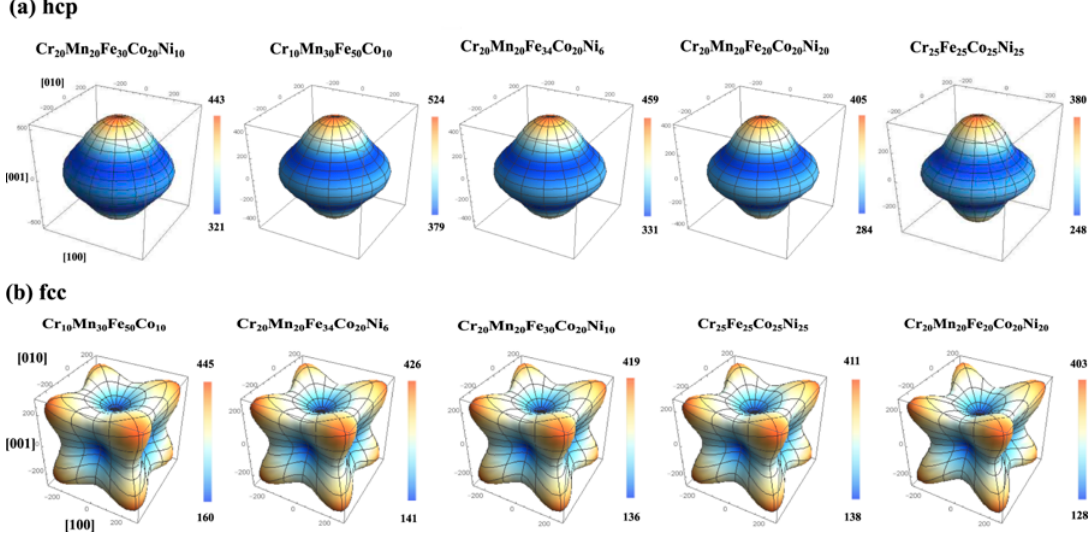
Figure 8. Directional dependence of Young’s modulus E (in GPa) of some MPE alloys in hcp and fcc structures (this figure is from Reference [91]).